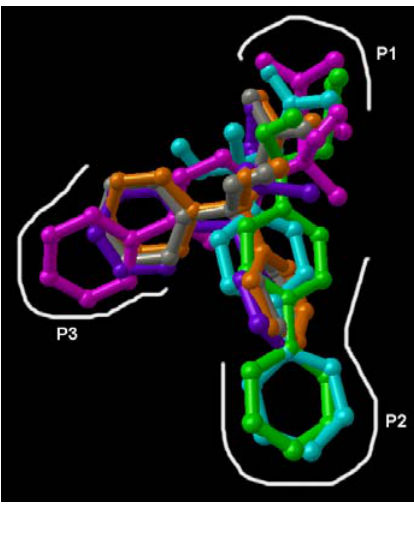
Figure 5. Anchor sites of COX-2 receptors and best docking poses of compounds 1 (green), 2 (blue), 3 (pink), 4 (gray), 5 (orange) and 6 (purple)